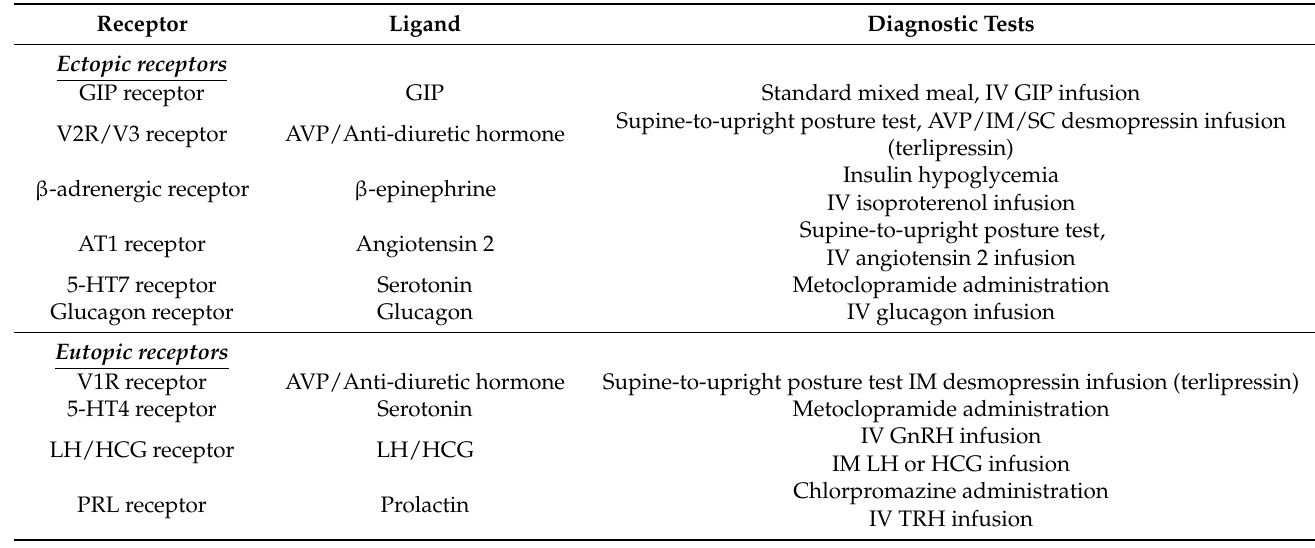
Table 3. Aberrant expression of G-coupled protein receptor in PBMAH, and their screening protocols. Adapted from [69–71]. After stimulation, a change in plasma cortisol > 25% from baseline was defined as a response (between 25% and 49%: partial response, >50% or greater: positive